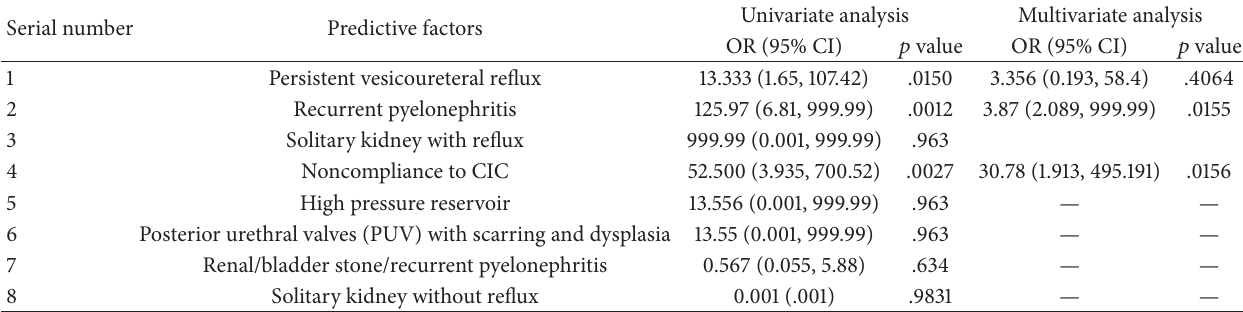
Table 5: Predictive factors for renal function deterioration on univariate logistic and multivariate regression analysis.